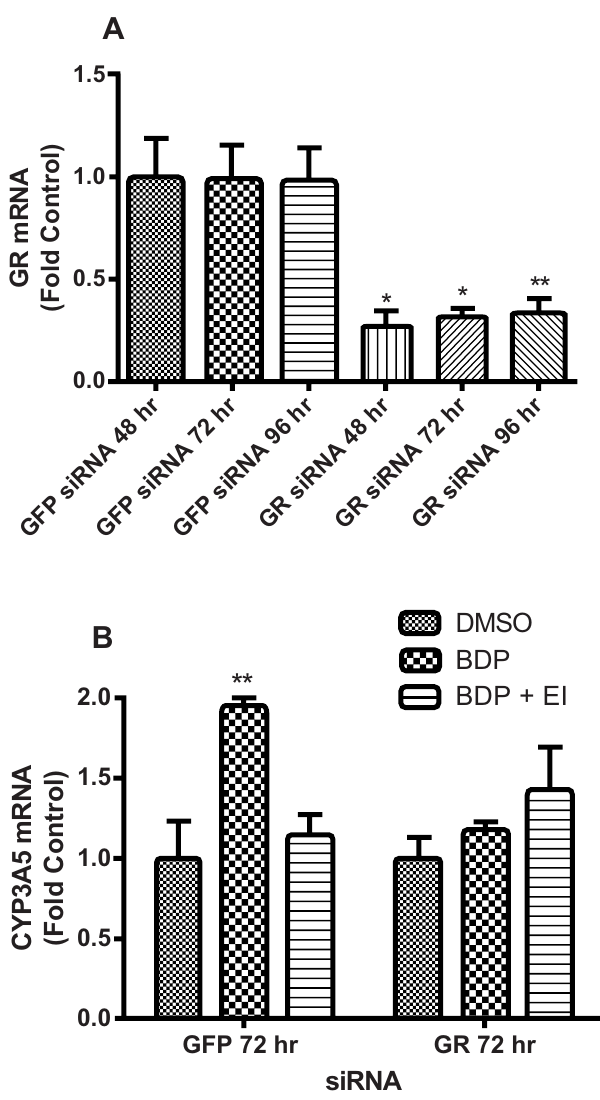
Figure 5. Glucocorticoid receptor (GR) siRNA blocks the induction of CYP3A5 by beclomethasone dipropionate (BDP). ( A ) siRNA-mediated GR knockdown in A549 cells at 48, 72, 96 h compared to “nonsense” GFP siRNA (negative control), expressed as fold over designated GFP control for each time point. ( B ) Cells were exposed to siRNA for 72 h then treated with DMSO, BDP, or BDP + esterase inhibitor (EI). Statistics used for data analysis were one-way ANOVA with Dunnett’s post-hoc test. Data are the mean and standard deviation from three replicates. * p<0.05, ** p<0.01.